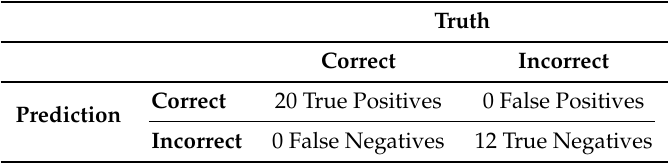
Table 3. Confusion Matrix for the Look Straight feedback.